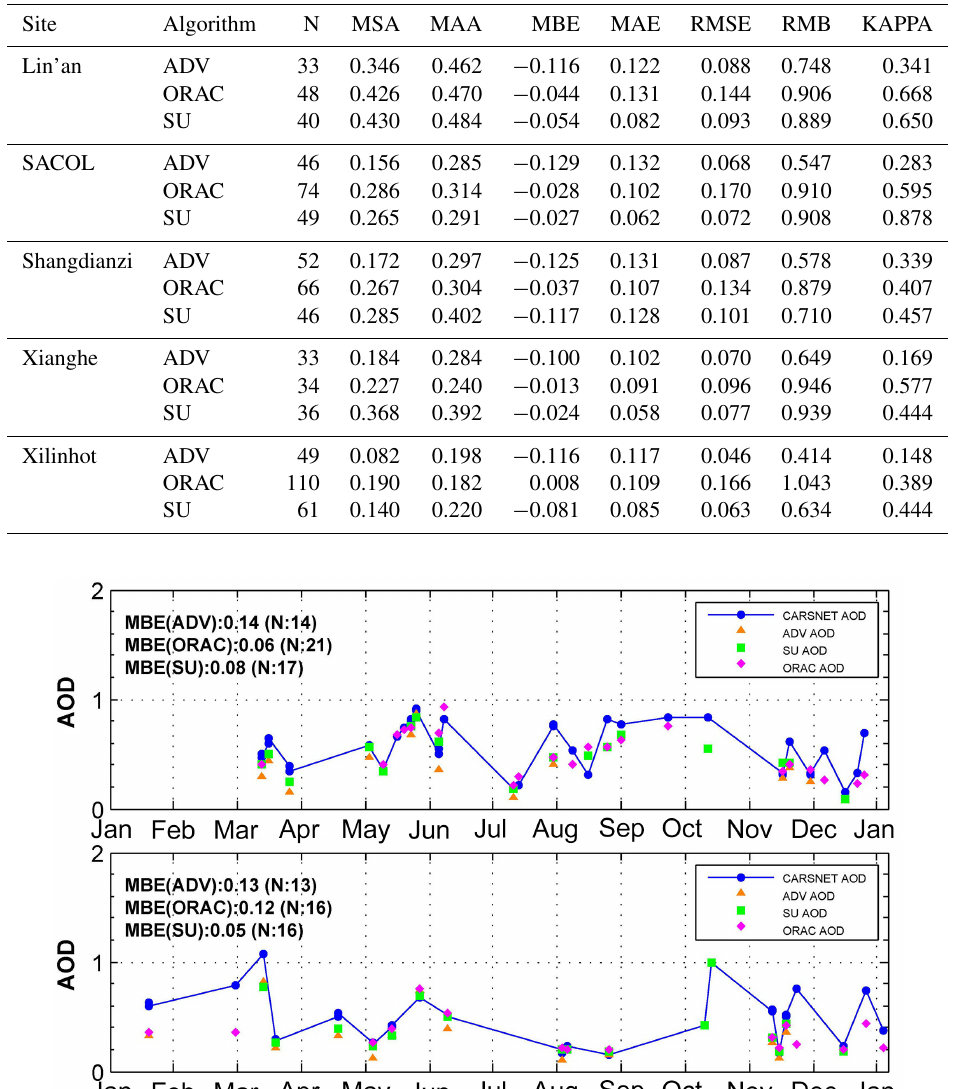
Table 6. Statistics of validation results of different products over different sites.